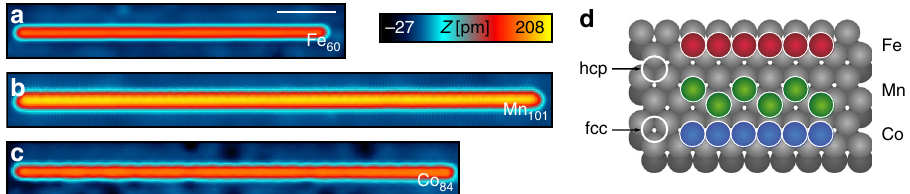
Fig. 1 Geometric structures of arti fi cial 3d transition-metal chains built on a Re(0001) surface. a Constant-current scanning tunneling microscope (STM) image of a linear chain of 60 hcp Fe atoms. The white scale bar corresponds to 3 nm. b Constant-current STM image of a zig-zag chain consisting of 101 Mn atoms, with adsorption sites alternating between the fcc and hcp hollow sites on the Re substrate. c Constant-current STM image of a linear chain of 84 hcp Co atoms. All data ( a – c ) are recorded with V = 6 mV, I = 0.2 nA. d Sketches of the atomic positions in ( a – c ).